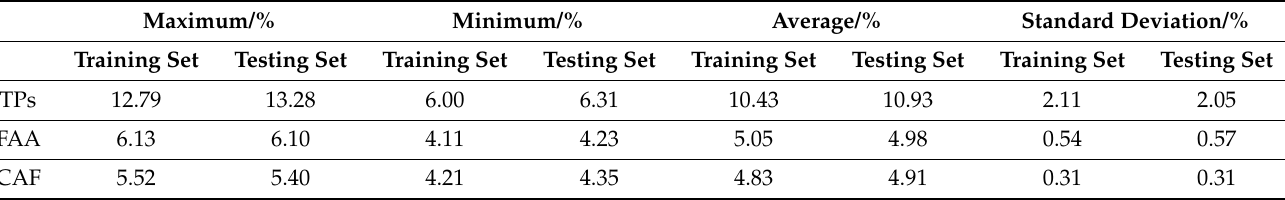
Table 2. The quality component content of the sample.